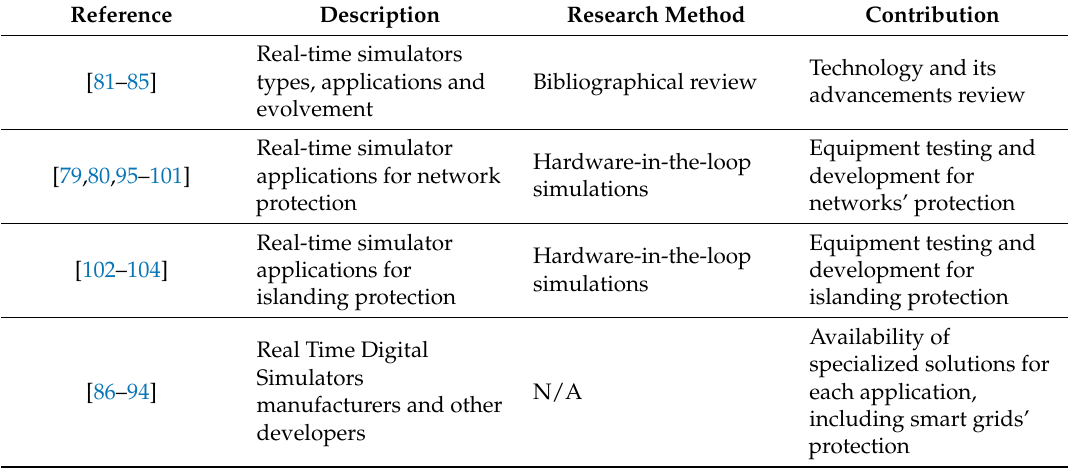
Table 3. Distribution networks protection